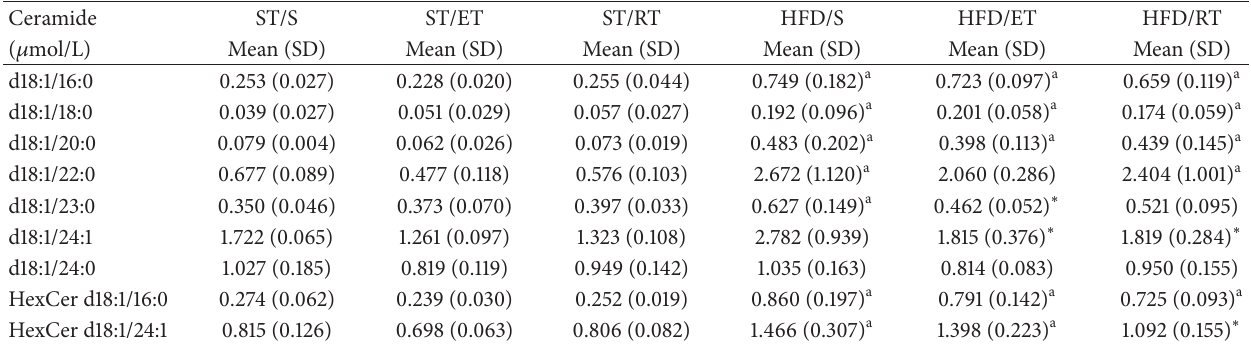
Table 3: Ceramide profiles of mice following a standard diet or HFD fed mice for 14 weeks.